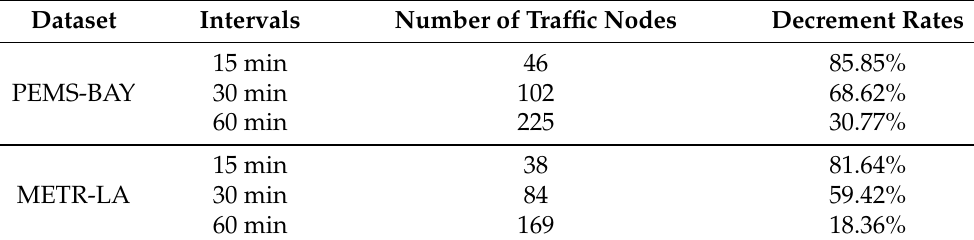
Table 2. The comparisons of number of nodes under DGR algorithm.